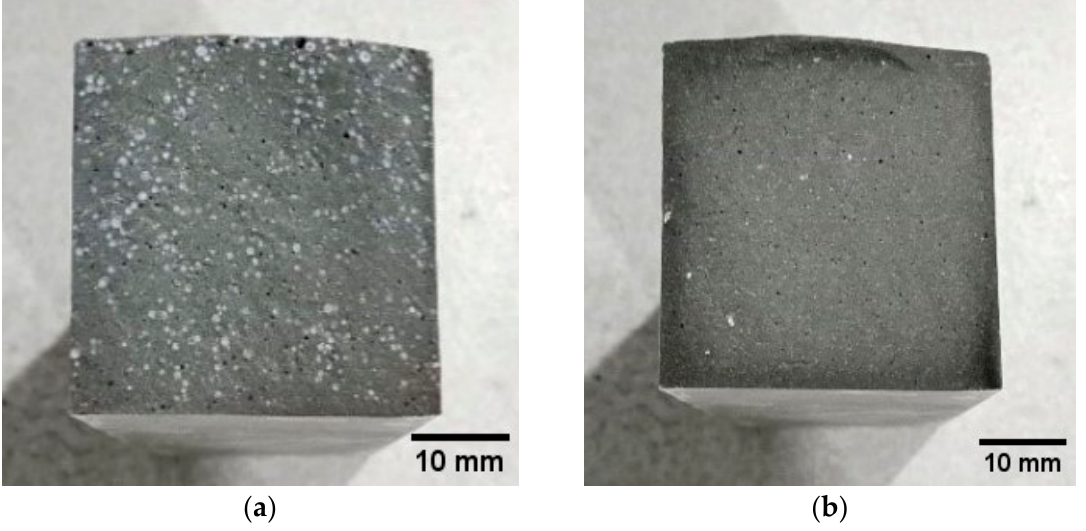
Figure 8. Cross-sections of samples. ( a ) V2 group, ( b ) V3 group.